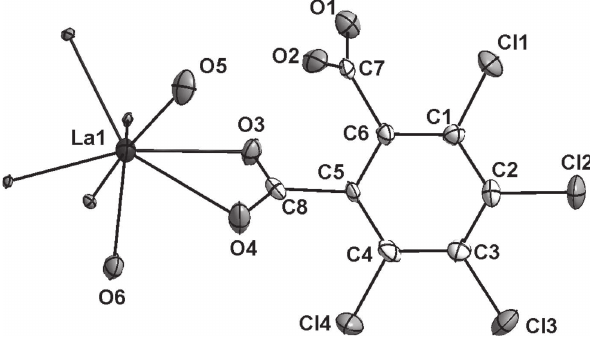
Table 1: Data collection and handling.